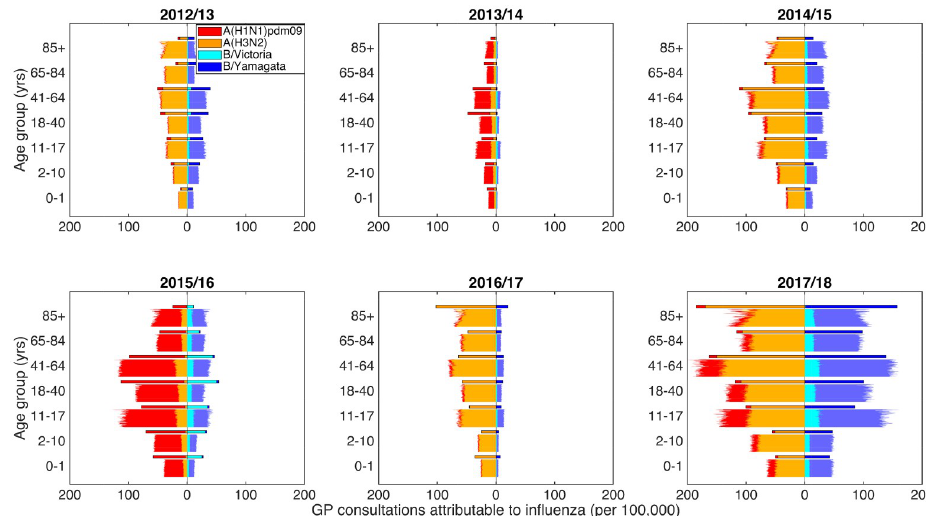
Fig 3. Predictive distributions for influenza positive GP consultations per 100,000 population. Stratified by influenza season and age bracket, we present back-to-back stacked bars per simulation replicate, with 100 replicates performed, each using a distinct parameter set representing a sample from the parameter distributions obtained from our parameter fitting scheme. Each panel corresponds to an individual influenza season. Within each panel, all age brackets are topped out by a thicker stacked horizontal bar plot, corresponding to the strain-stratified point estimates for the empirical data. In all panels, the left side depicts data pertaining to type A influenza viruses (red shading denoting the A(H1N1)pdm09 subtype, orange shading the A(H3N2) subtype). In an equivalent manner, the right side stacked horizontal bars present similar data for type B influenza (cyan shading denoting the B/Victoria lineage, dark blue shading the B/Yamagata lineage). We see a reasonable qualitative model fit to the